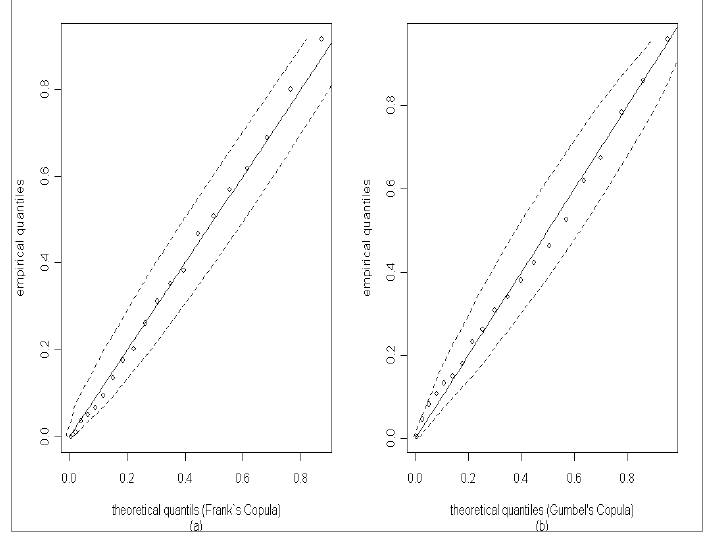
Figure 7. Comparative test Tau -plots using a 95% confidence level. (a) Dependence between intensities fitted by Frank copula. (b) Dependence between fundamental frequencies fitted by Gumbel